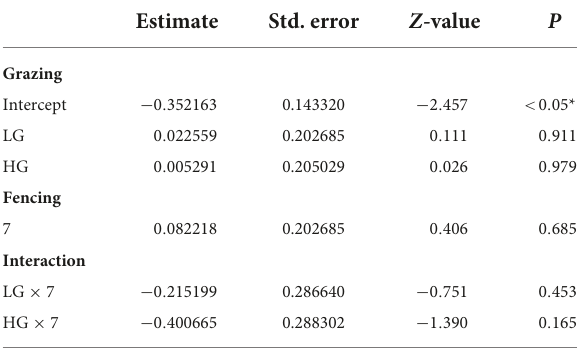
TABLE 5 Results of generalized linear mixed models (GLMMs) for species Simpson diversity of insects sampled after 3 or 7 fencing years in three grazing treatments in a desert steppe: Ungrazed plot (CK, used as reference), light grazed (LG), and heavily grazed (HG).